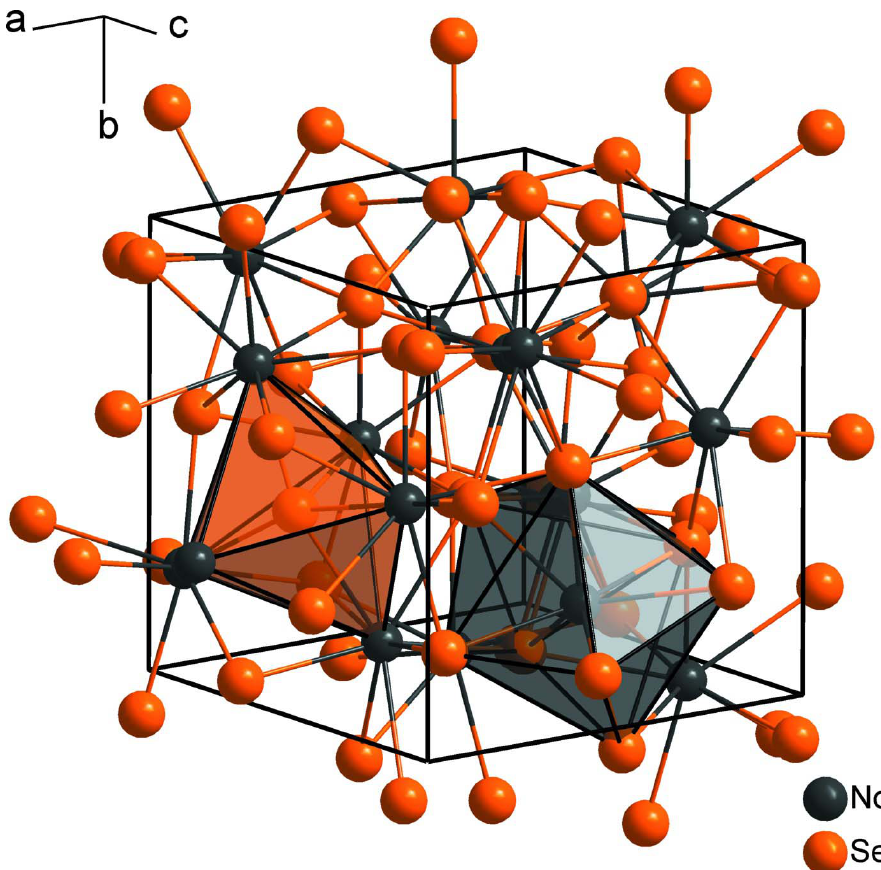
Figure 1 Crystal structure of C-Type Nd